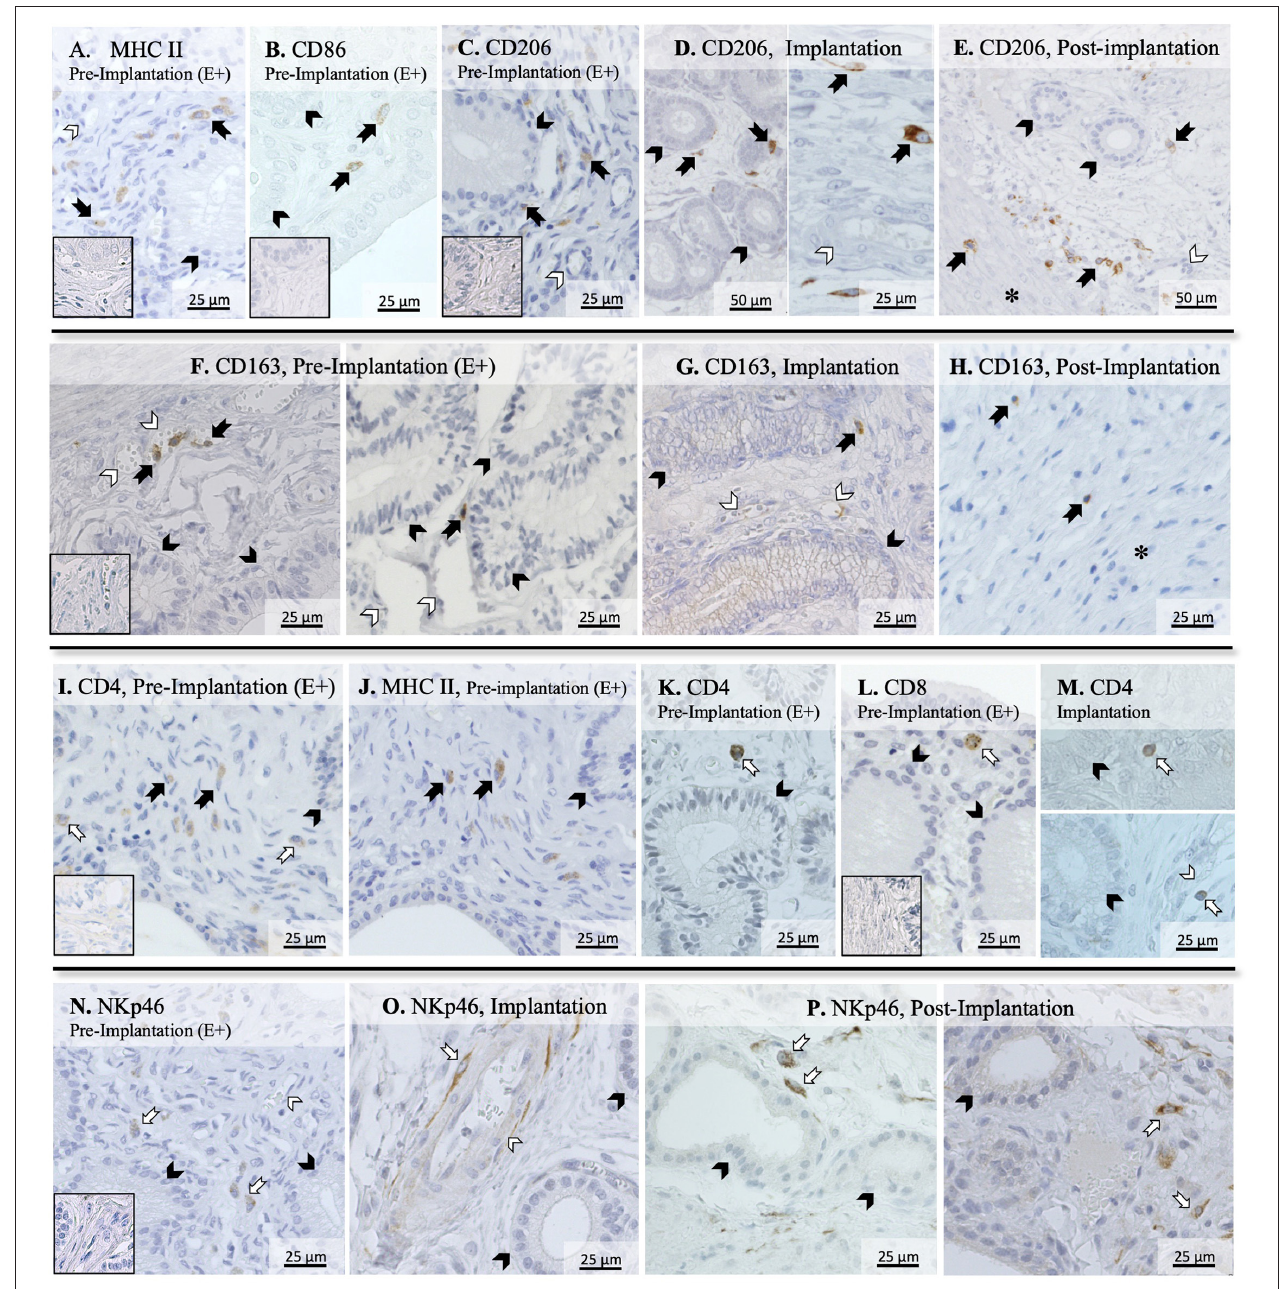
FIGURE 2 | Immunolocalization of selected markers of macrophages and lymphocytes in the canine uterus. Immunohistochemical detection of MHCII, CD86, CD206, CD163, CD4, CD8, and NKp46 (encoded by NCR1 ) at selected stages during early pregnancy. MHCII ( A) and CD86 (B) were localized in individual macrophages distributed in the superficial layer of the endometrium during pre-implantation. (C–E) CD206 signals were observed in macrophages localized in the superficial layer of the endometrium during pre-implantation, around uterine glands (C) . At the time of implantation, CD206-positive macrophages were present around uterine glands (D , left panel ) , and scattered in the endometrium during implantation (D , right panel ) , and post-implantation period (E) . Isolated cells could also be identified in the myometrium in Post-Imp samples (E) . (F–H) CD163 was expressed by macrophages detected in the superficial layer of the endometrium during pre-implantation (F) and implantation (G) . At post-implantation, single CD163-positive macrophages were localized in deep layers of the endometrium, close to the myometrium (H) . To differentiate CD4-expressing macrophages (MHCII + ) and lymphocytes (MHCII − ), consecutive slides were stained against CD4 (I) and MHCII (J) . Both CD4 (K) and CD8-positive lymphocytes (L) were localized in the superficial layer of the endometrium during pre-implantation. During implantation (M) , individual CD4 + lymphocytes were identified in endometrial superficial layer (top panel) and within blood vessels (bottom panel). Nkp46 (NK cells) were localized in the superficial layer of the endometrium (N) and around blood vessels (O) during pre-implantation and implantation stages. In samples from post-implantation stage (P) , NK cells were identified around superficial (left panel) and deep uterine glands (right panel). (solid arrow = macrophages; open arrow = lymphocytes; closed arrowhead = uterine gland; open arrowhead = blood vessel; asterisk = myometrium). No staining was observed in the isotype controls [inset in (A–C,F,I,L,N)